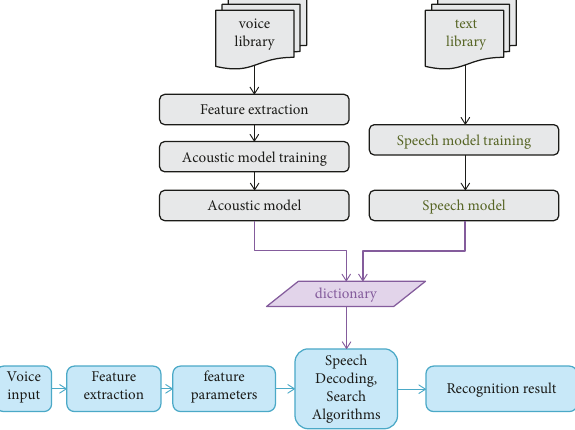
Figure 4: Speech recognition